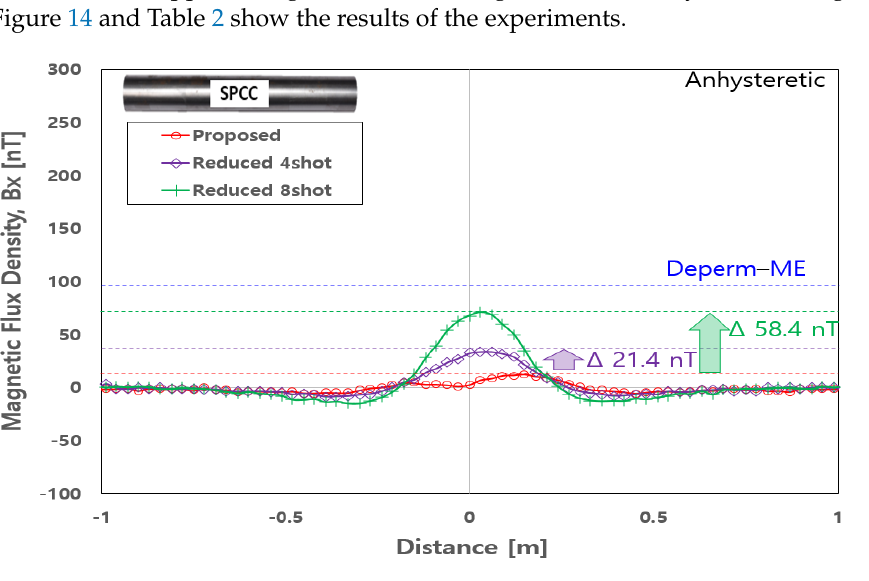
Figure 14. Experimental results obtained with a reduced number of magnetic fields. Table 2. Measured results of the SPCC by reducing the demagnetization time.